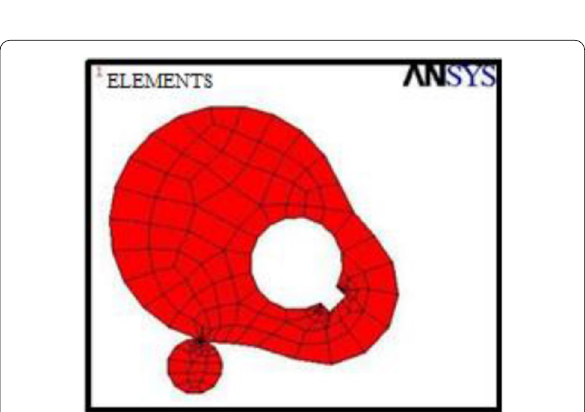
Figure 6 Mesh generation when the follower located at 90° with the cam